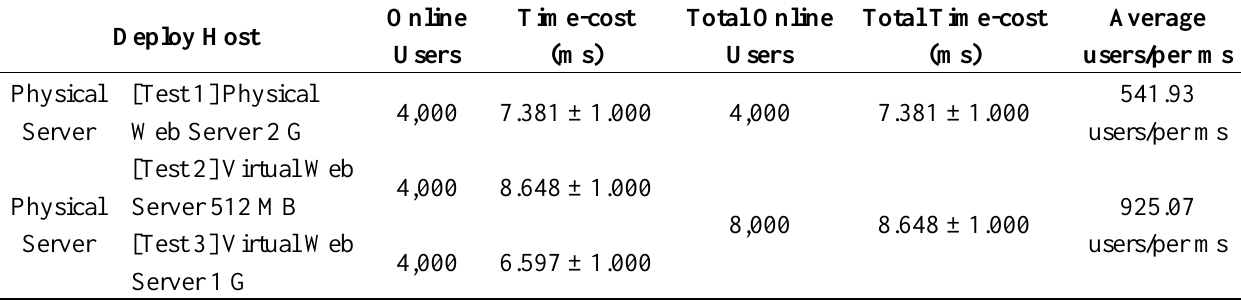
Table 8. Testing results for 4,000/8,000 online